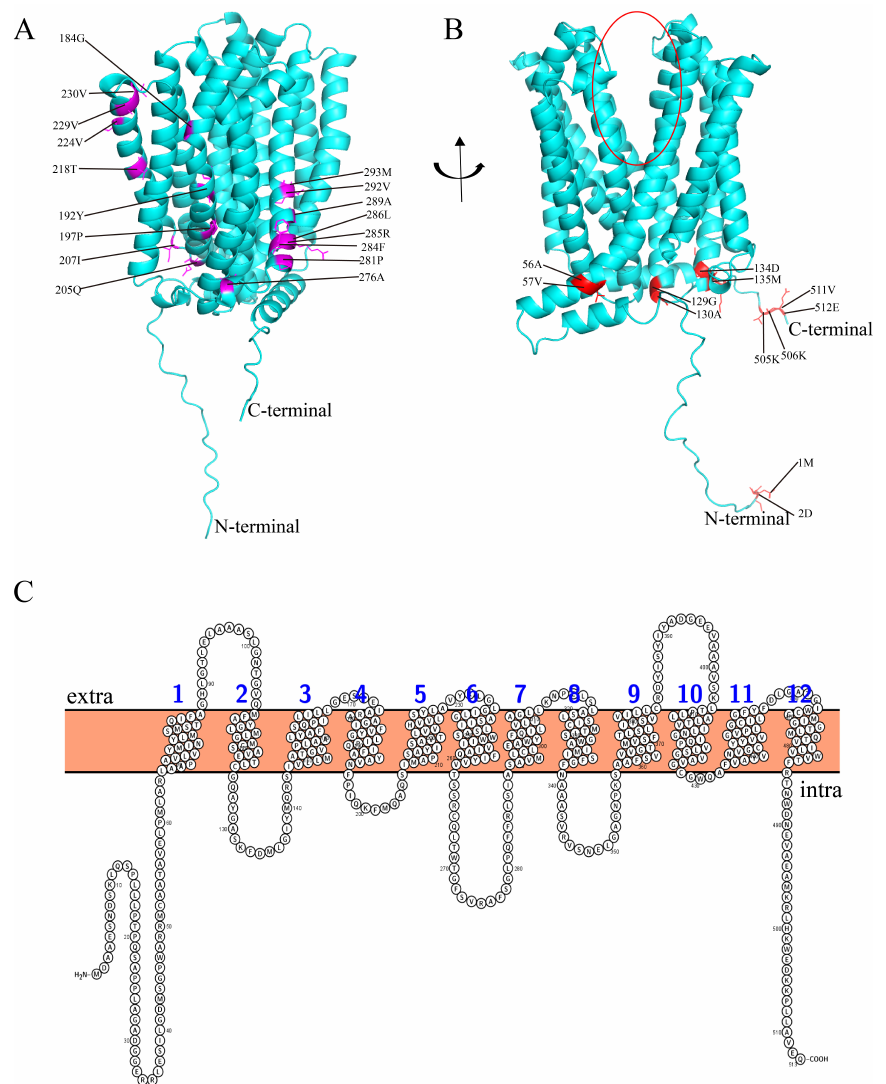
Figure 5. Analysis of 3D structure, functional divergence and coevolution sites in wheat TaMATE1 protein. ( A ) The 3D structure predicted by AlphaFold and 17 key functional divergence sites labelled with purple. ( B ) The 12 sites responsible for coevolution are coloured red. Red circle represents the central cavity of TaMATE. ( C ) The transmembrane helices of TaMATE predicted with Protter webserver; 1–12 represents the 12 transmembrane helices of